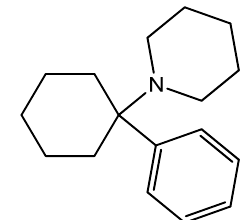
Figure 14. Phencyclidine.